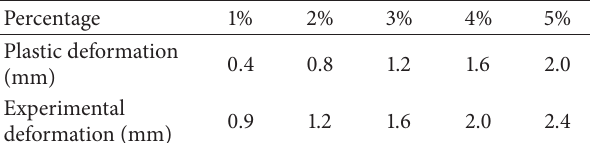
Table 3: Cold compression deformation scheme.